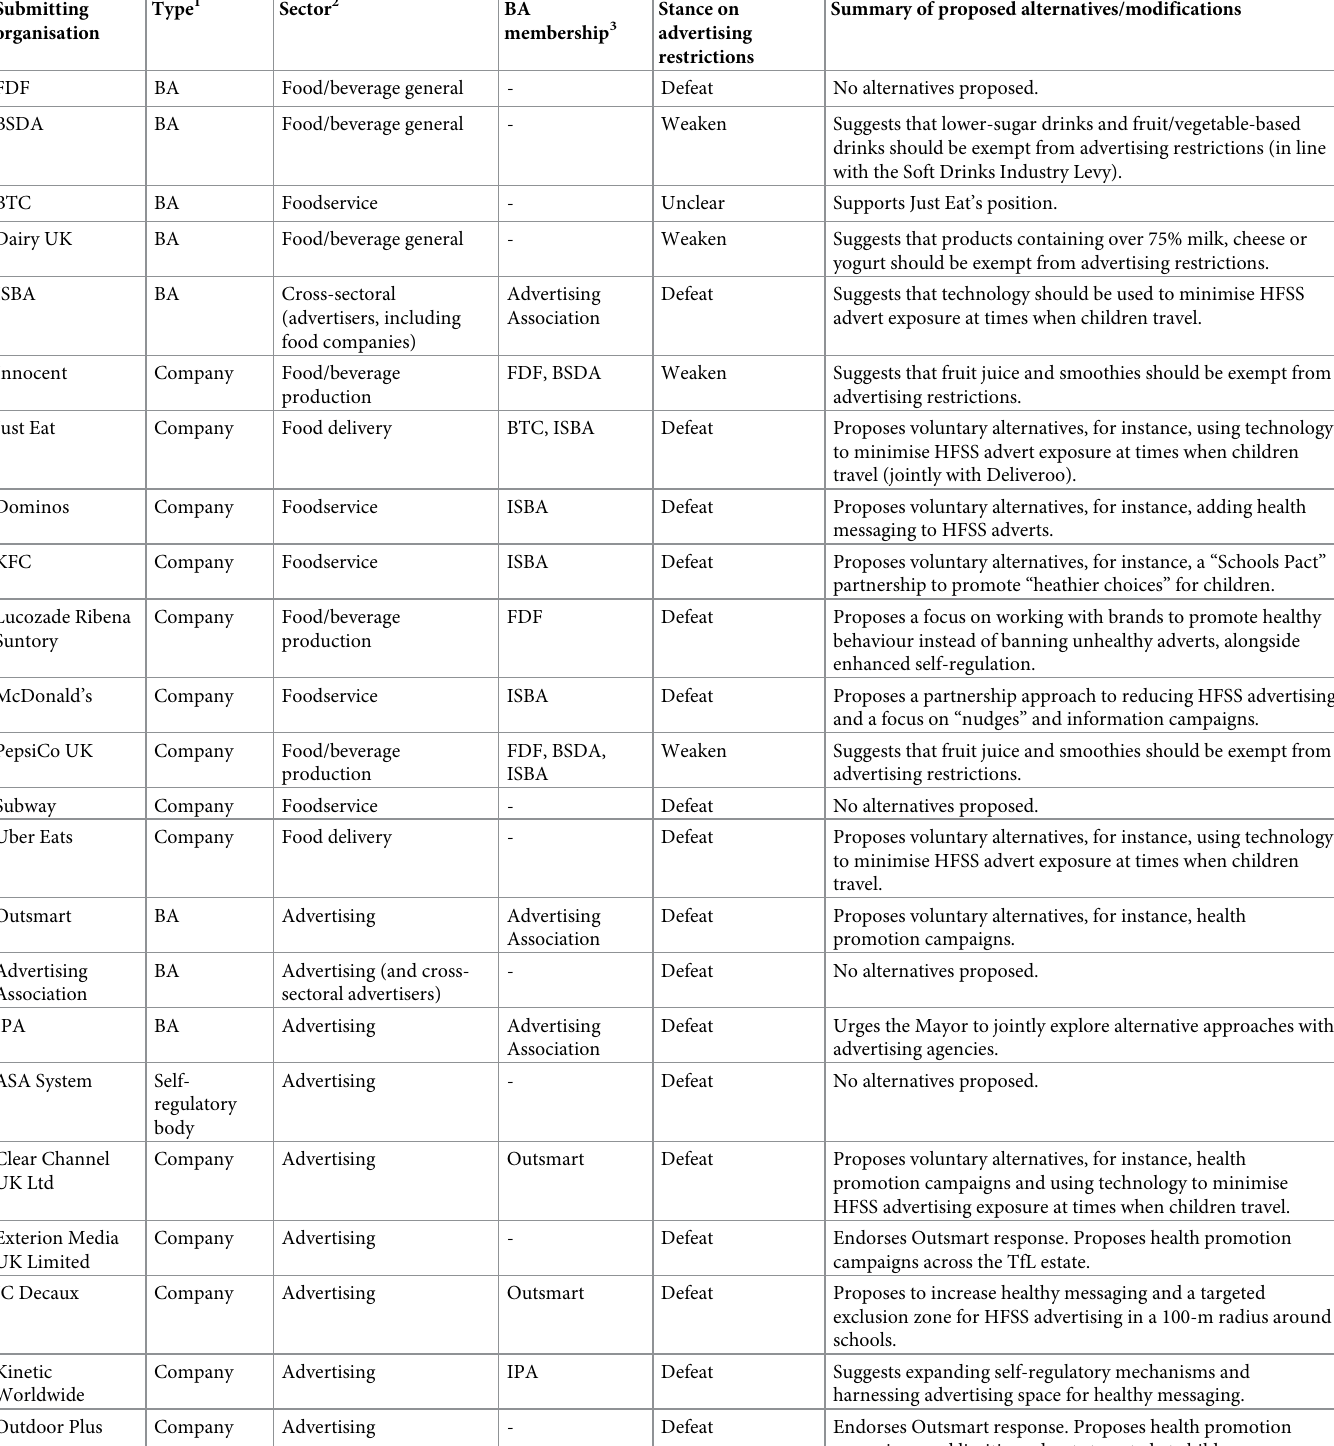
Table 2. List of organisations that opposed the advertising restrictions as proposed in the draft London Food Strategy consultation. Policy aims regarding the pro- posed advertising restrictions are categorised based on the PDM—defeat (no advertising restrictions), delay (delayed implementation), weaken (advertising restrictions in a weaker form than